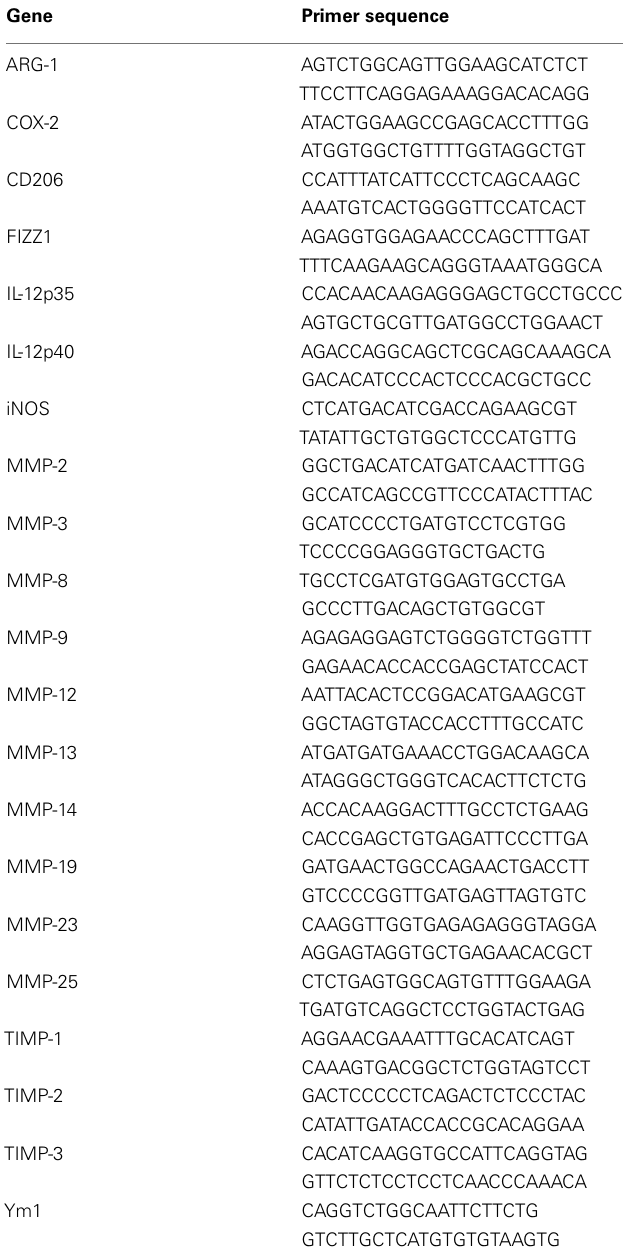
Table 1 | Primer sequences used for quantitative RT-PCR